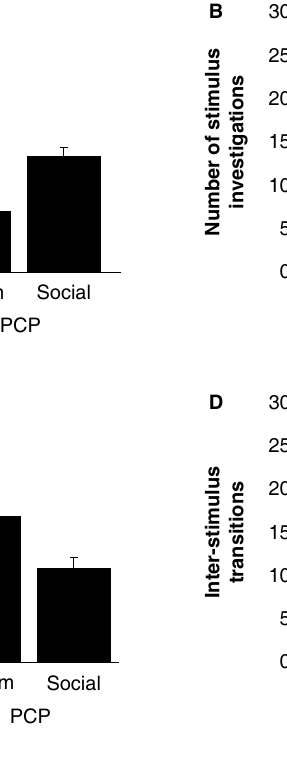
group showed a signifi cant difference in latency to fi rst visit the novel social stimulus than the familiar social stimulus (C) . Treatment did not affect the number of transitions between stimuli (D) . n = 7–8 per treatment. Inamin = inanimate stimulus. Data are mean ± SEM. # p < 0.05 vs. familiar/same treatment group.